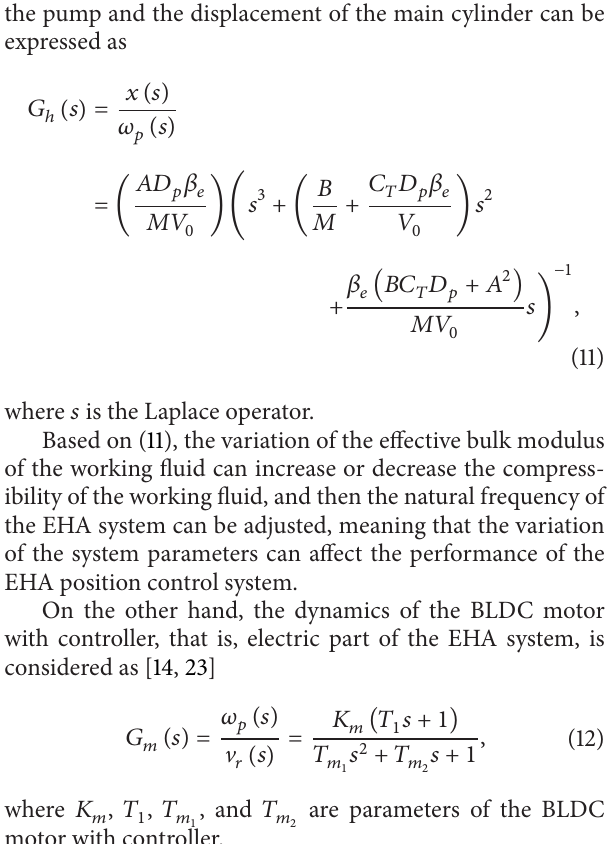
Figure 5: Bode plots of the closed loop nominal model and the closed loop actual system with a proportional